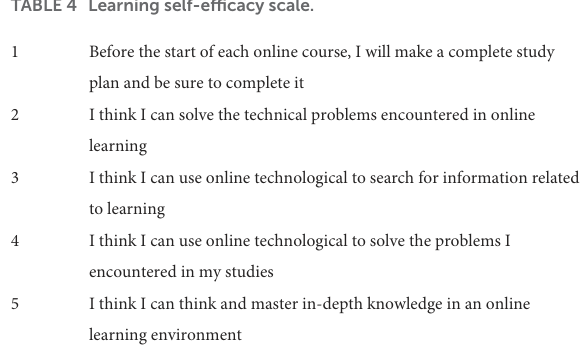
TABLE 4 Learning self-efficacy scale.